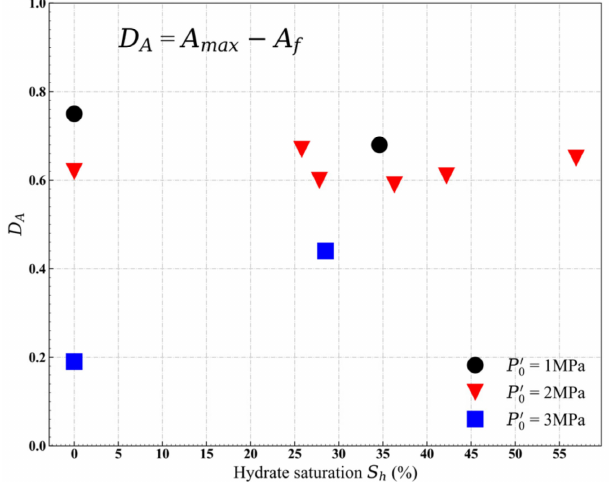
Figure 6. D A value versus S h of sand